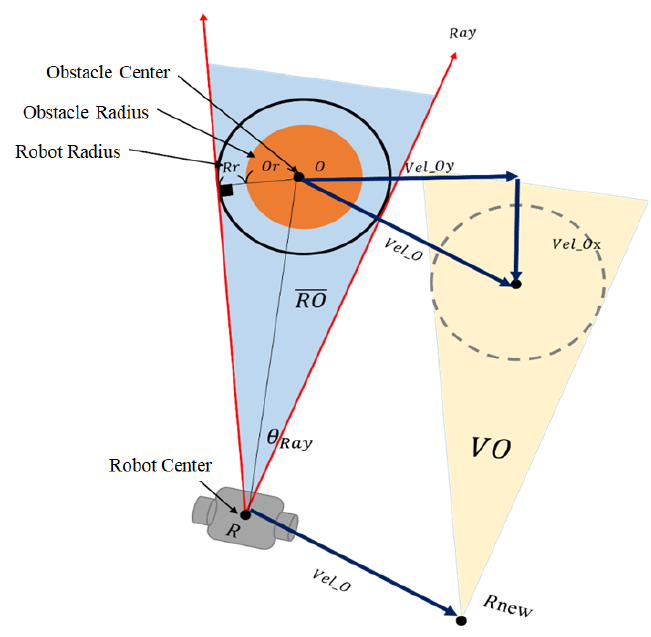
Figure 8. Velocity obstacle area.